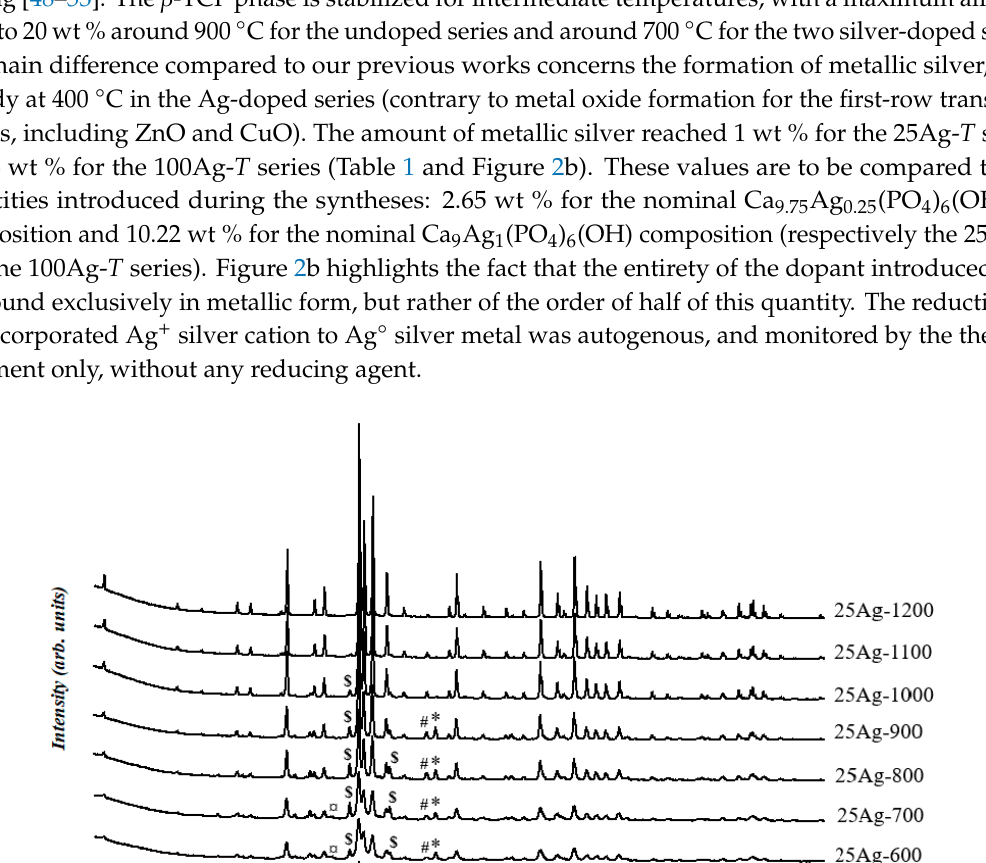
Figure 2. Thermal variation in a ) the two main phase contents (squares: HAp; circles: TCP) from the biphasic calcium phosphates (BCP) samples and b ) the metallic silver amount (stars) for the undoped 0Ag- T series (black symbols), the 25Ag- T series (blue symbols), and 100Ag- T series (red symbols). Dotted lines indicate the nominal silver amounts, and lines are only guides for the eyes.